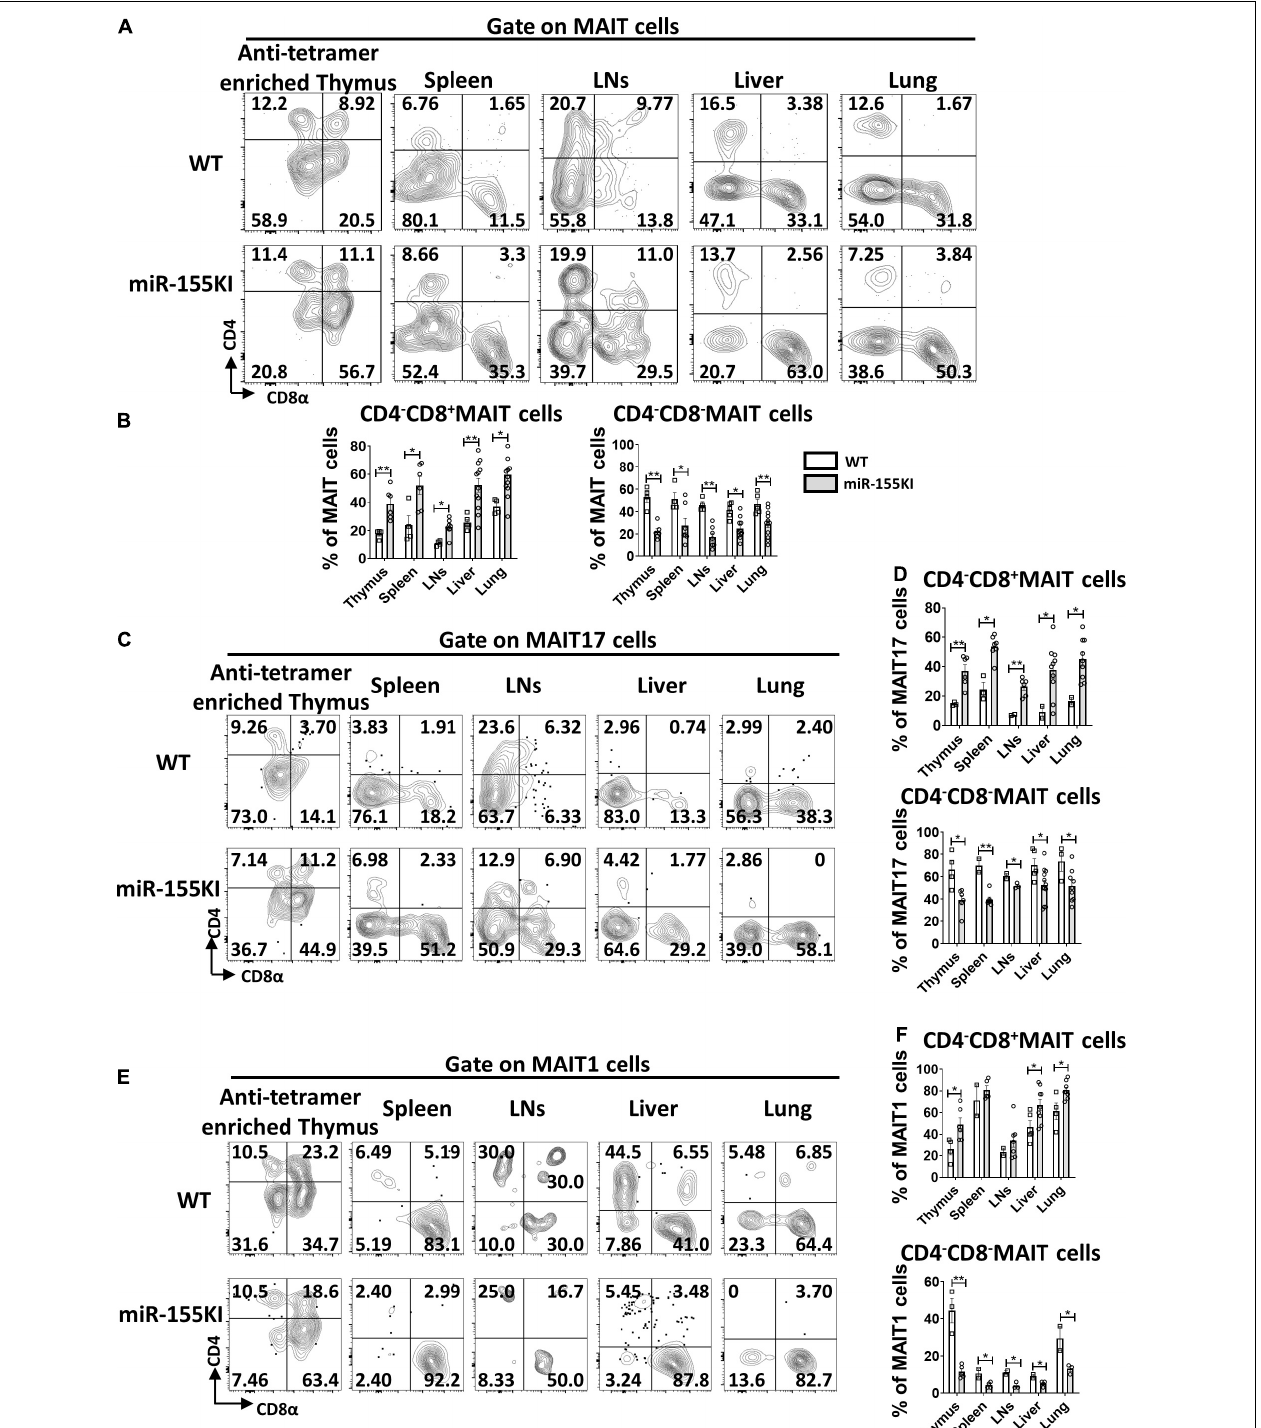
FIGURE 4 | miR-155 increases CD4 − CD8 + subset and decreases CD4 − CD8 − subset in thymic and peripheral MAIT cells. (A) Flow cytometry analysis of CD4 and CD8 coreceptor expression on MAIT cells from thymus, spleen, LNs, liver, and lung from WT and miR-155 KI mice. (B) Percentage of MAIT cell subsets that express CD8, or neither coreceptor [CD4 − CD8 − ] in the indicated organs. (C) Analysis of CD4 and CD8 expression on MAIT17 cells. (D) Percentages of CD4 − CD8 + subset and CD4 − CD8 − subset in MAIT17 cells. (E) CD4 and CD8 coreceptor expression pattern on MAIT1 cells in the indicated organs. (F) Percentages of CD4 − CD8 + subset and CD4 − CD8 − subset in MAIT1 cells. Data are from at least three independent experiments. Each mouse is represented as one dot. 3–8 mice for each group. Data were analyzed by unpaired t -test. * p < 0.05, ** p < 0.01 compared to WT.